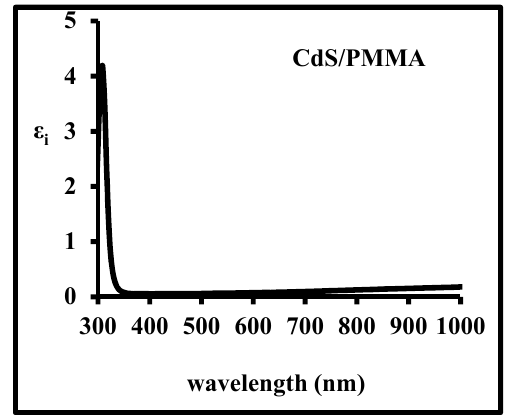
Fig. 8: The variation of the imaginary part of the dielectric constant as a function of the wavelength for CdS/PMMA thin